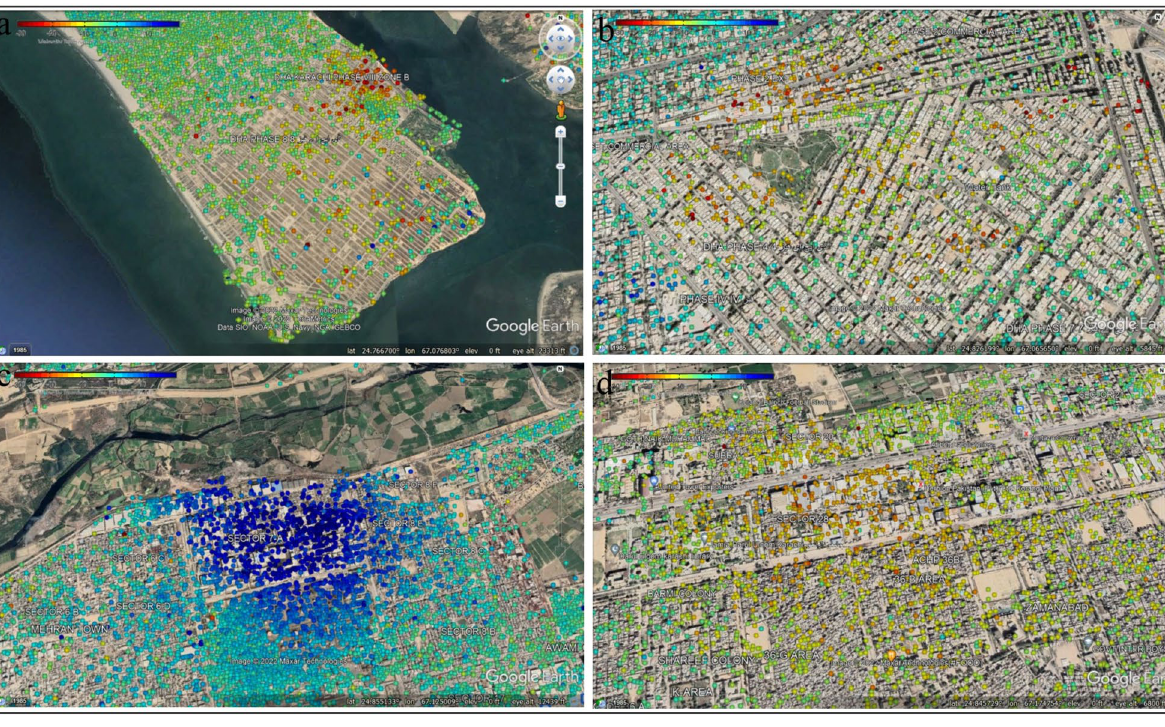
Figure 11. Vertical displacement in Karachi, ( a ) DHA Karachi Phase VIII Zone B, ( b ) DHA Karachi Phase 4, ( c ) Sector 7-A, ( d ) Sector